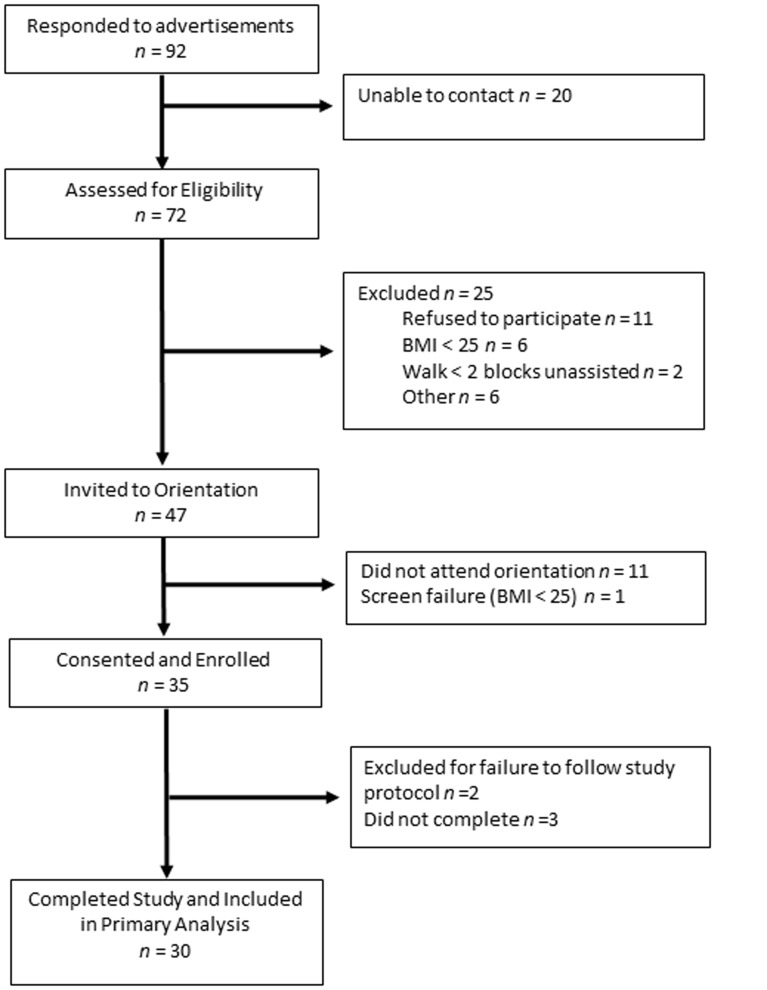
Flow diagram includes data on number of respondents to study advertisements, participant enrollment, number of participants who completed the study, and primary analysis.